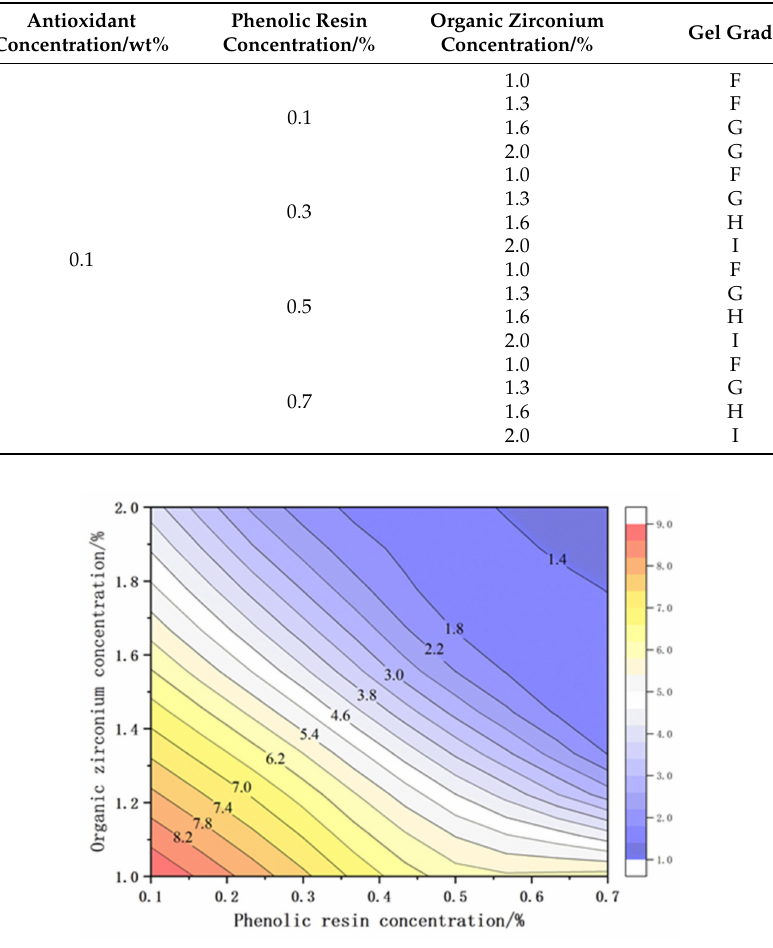
Figure 3. Gel formation time of the secondary cross-linking reactions. Table 4. The recipe compositions of the samples JM186, #1, and